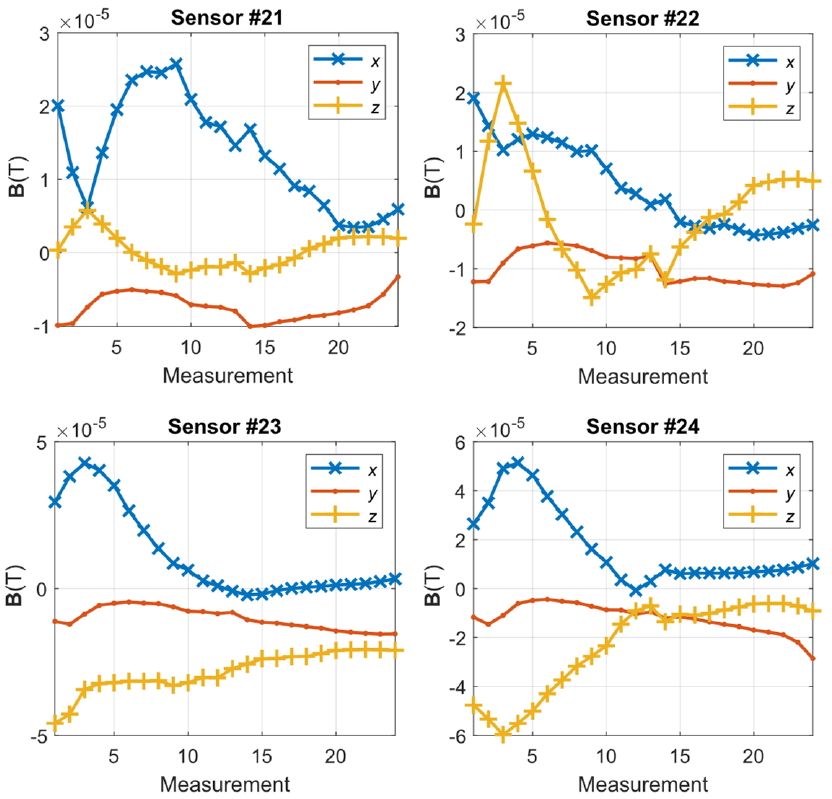
Figure 13. The x -, y -, and z -direction magnetic induction for sensors 21–24 for the specimen discontinuity area.